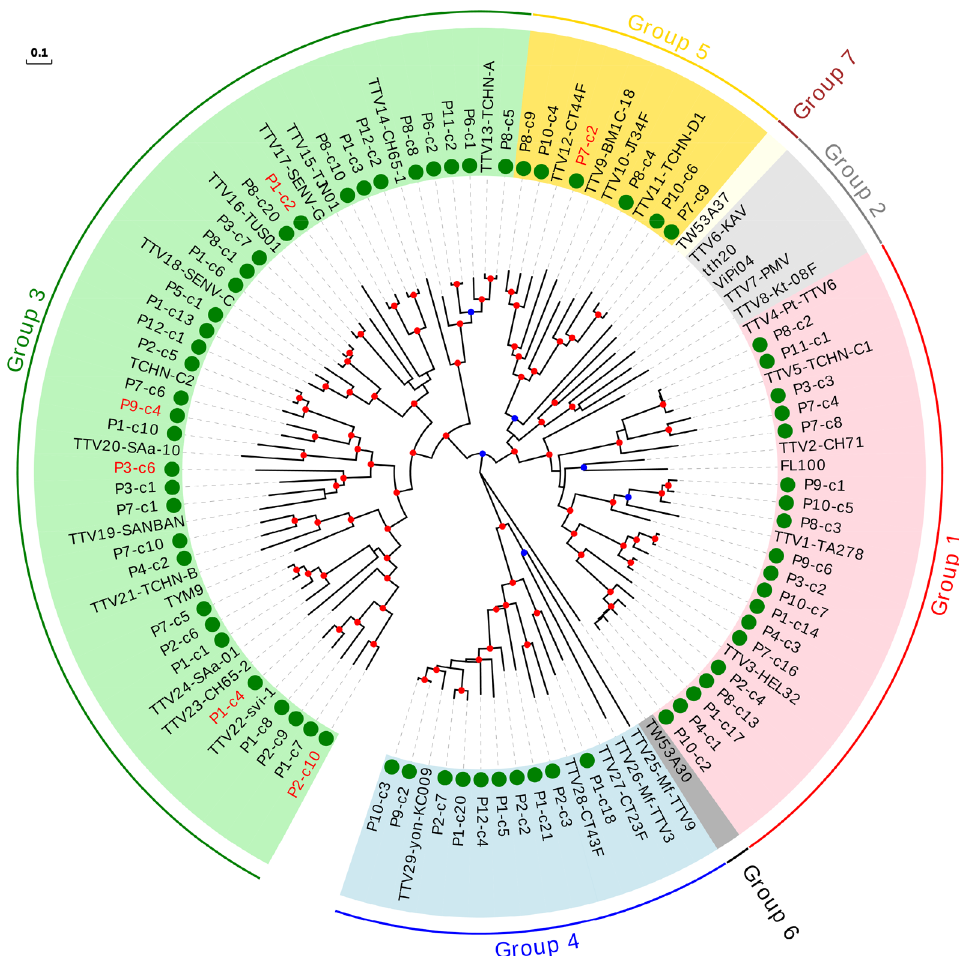
Figure 4. Phylogenetic tree for the ORF1 including the representative genotypes from TTV genus. Sequences described in this study are marked with a green circle. Those sequences that could be considered as new species are labelled in red. 0.7–0.85 and 0.85–1.0 bootstrap value ranges are indicated with blue and red circles, respectively. Scale bar indicates evolutionary distance in nucleotide substitutions per